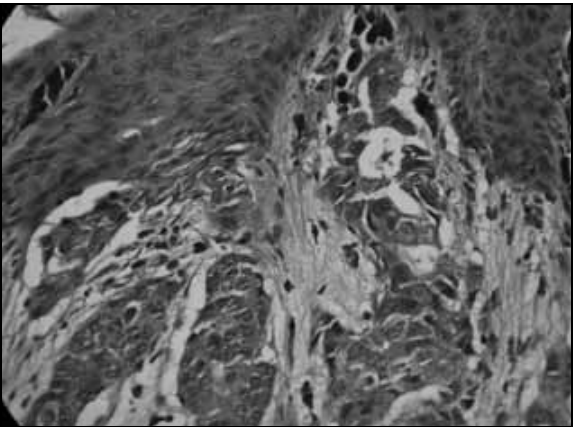
Figura 2 – Invasão do derma da papila por carcinoma ductal invasivo (HE, 400×) HE: hematoxilina e eosina. CAM positivo (14,58%)